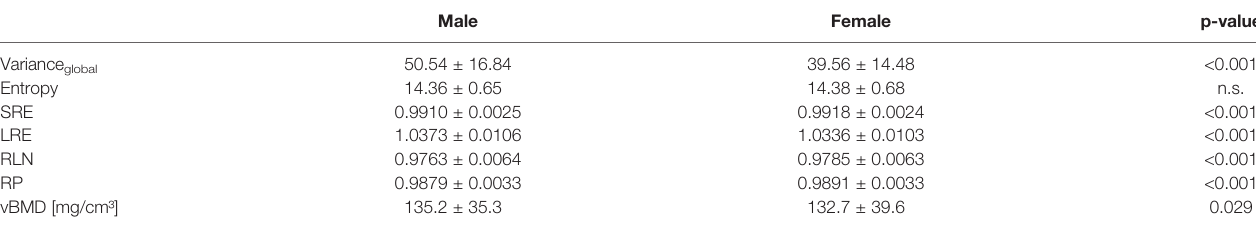
TABLE 8 | Texture features and vBMD, averaged from T4-L5 and grouped by gender.